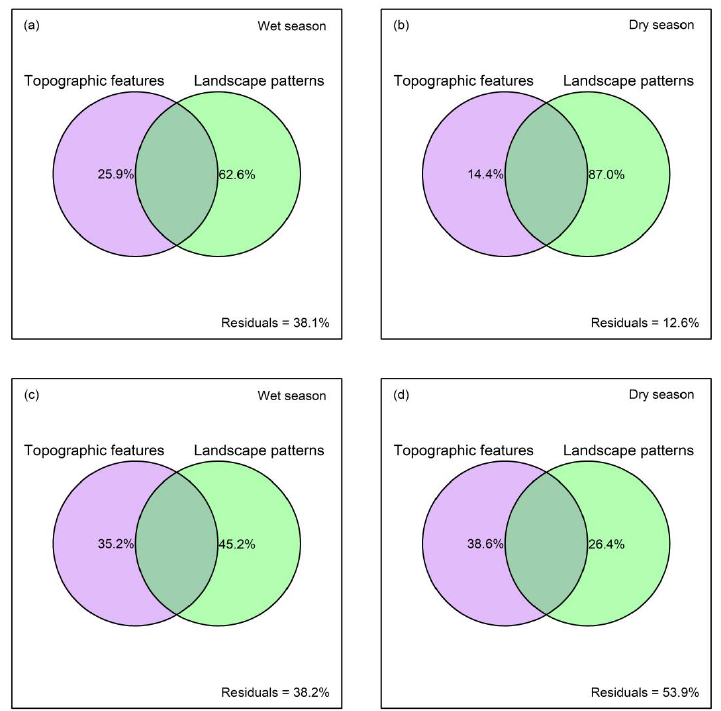
Figure 5. Diagrams describing the partitions of variation of water quality indicators by topographic features and landscape patterns at catchment ( a , b ) and buffer ( c , d ) scale in different seasons. Values less than zero are not displayed.